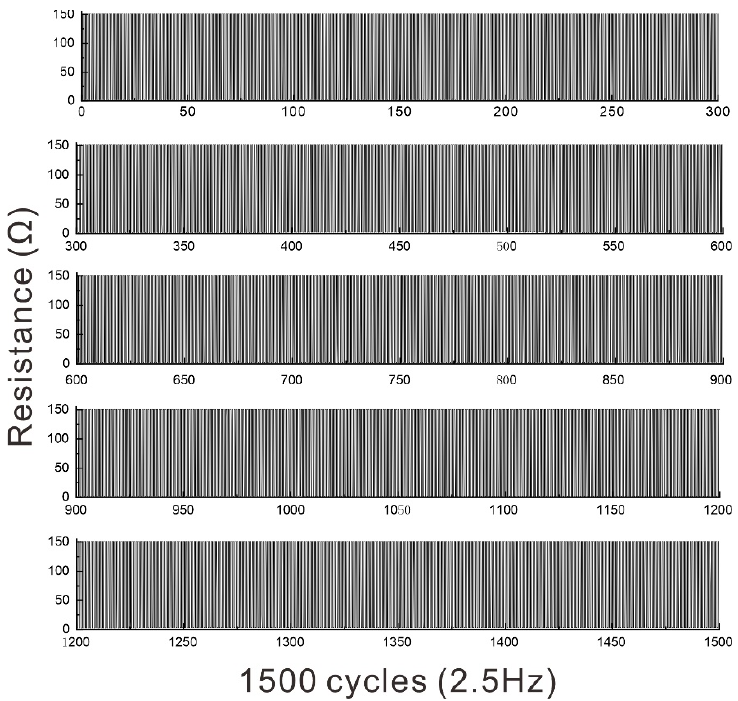
Figure A3. 1500 cycles of the resistance variation at 2.5 Hz.